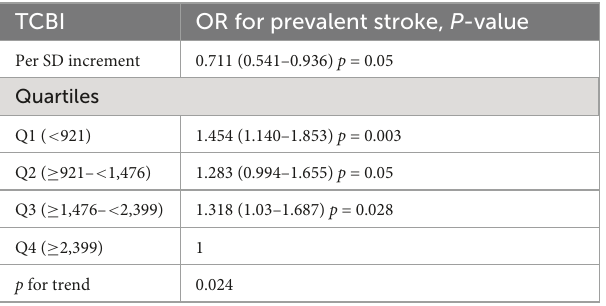
TABLE 4 Association of triglycerides, total cholesterol, and body weight index (TCBI) with stroke (after a 1: 3 match). TCBI OR for prevalent stroke, P